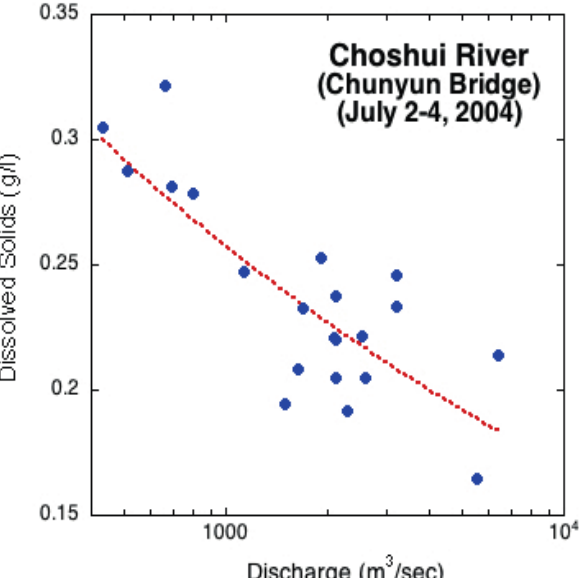
Fig. 9 Dissolved solids (expressed in meq) versus reported water discharge at the Chunyun Bridge (station J), 2–4 July 2004.